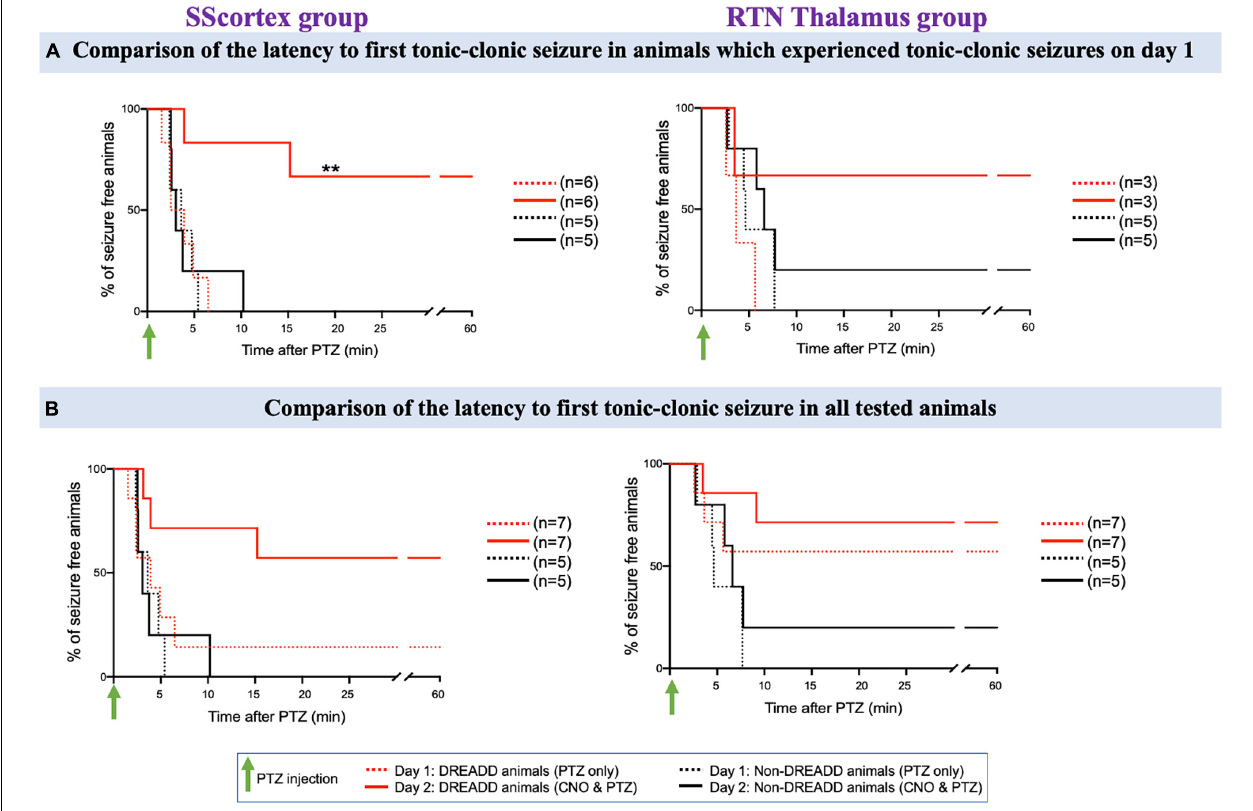
FIGURE 9 | (A) Comparison of the latency to first tonic-clonic seizure in animals, which experienced tonic-clonic seizures on day 1. (B) Comparison of the latency to first tonic-clonic seizure in all tested PV Cre /Gq-DREADD and non-DREADD WT controls of the SScortex group and the RTN thalamus group between day 1 (PTZ only treated) and day 2 (CNO and PTZ treated). Comparisons between the treatment groups were made using log-rank test. ** p =